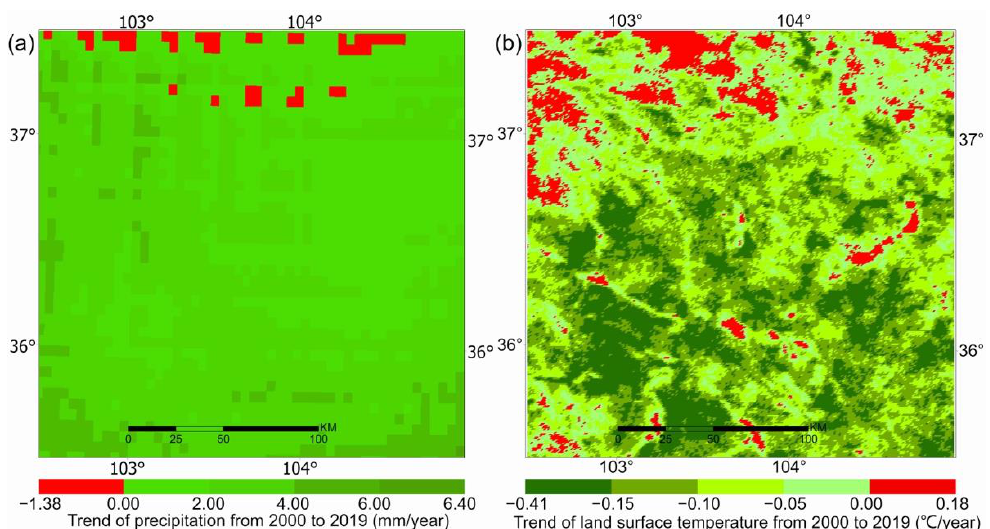
Figure 11. Trends of the growing season precipitation ( a ) and temperature ( b ) in the study area for the years from 2000 to 2019.